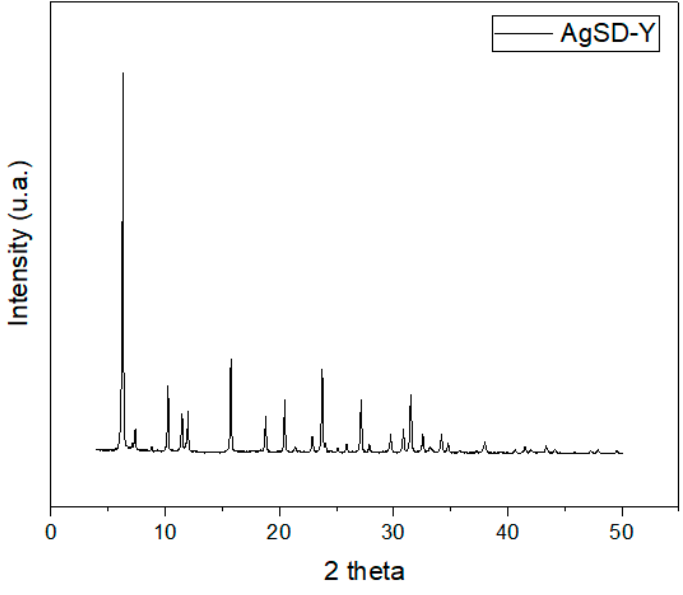
Figure 3. Diffractograms of AgSD-Y zeolite. Figure 3. Di ff ractograms of AgSD-Y